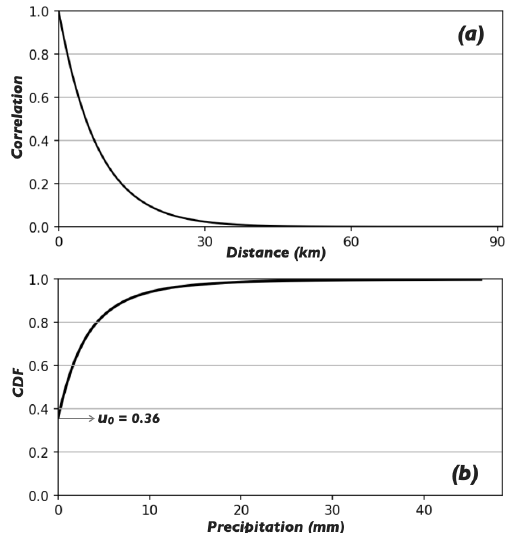
Figure 3. (a) The exponential correlation function used in the gen- eration of the Gaussian random fields Z T . (b) The rainfall CDF used in the generation of the true rainfall fields, where the spatial intermittency u 0 is